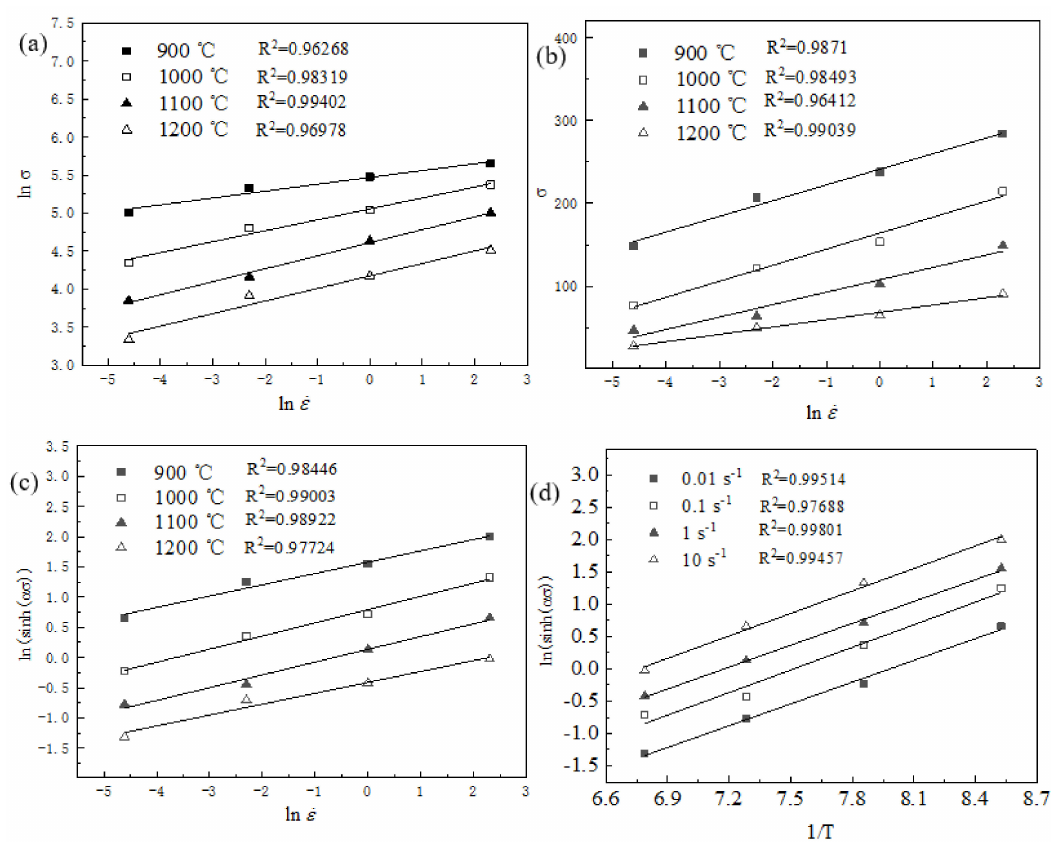
. ε . ε ; ( b ) σ − ln ; ( c ) ln[sinh( ασ )] − ln